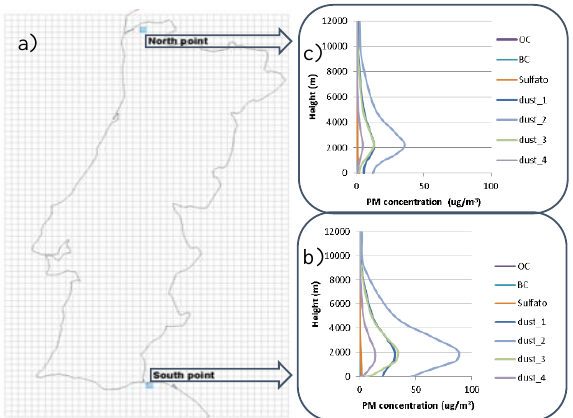
Figure 6. Vertical distribution of PM concentration: a) localization of the two points, b) results for South point and c) results for North point.